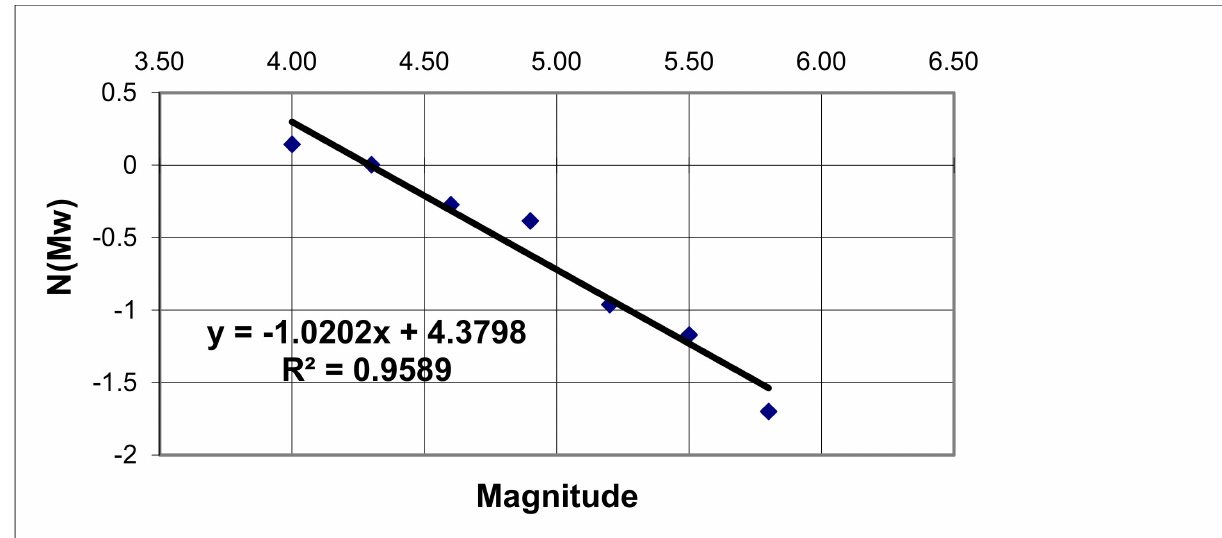
Figure 7. Gutenberg–Richter recurrence relationship curve for source zone